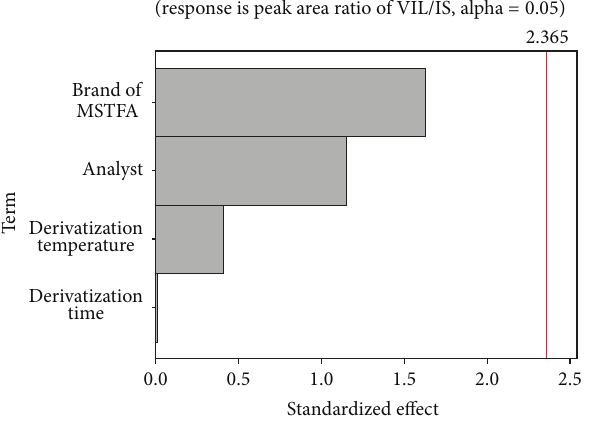
Figure 4: Pareto chart of the standardized